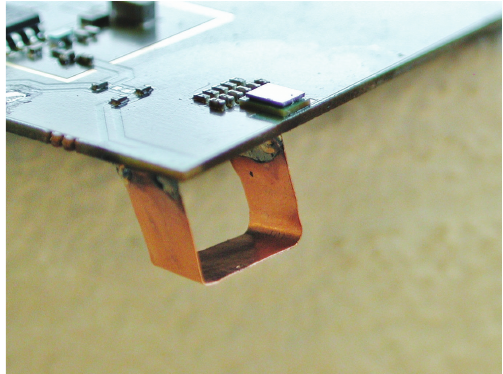
Figure 12: Antenna miniaturization demonstrator, bottom view.